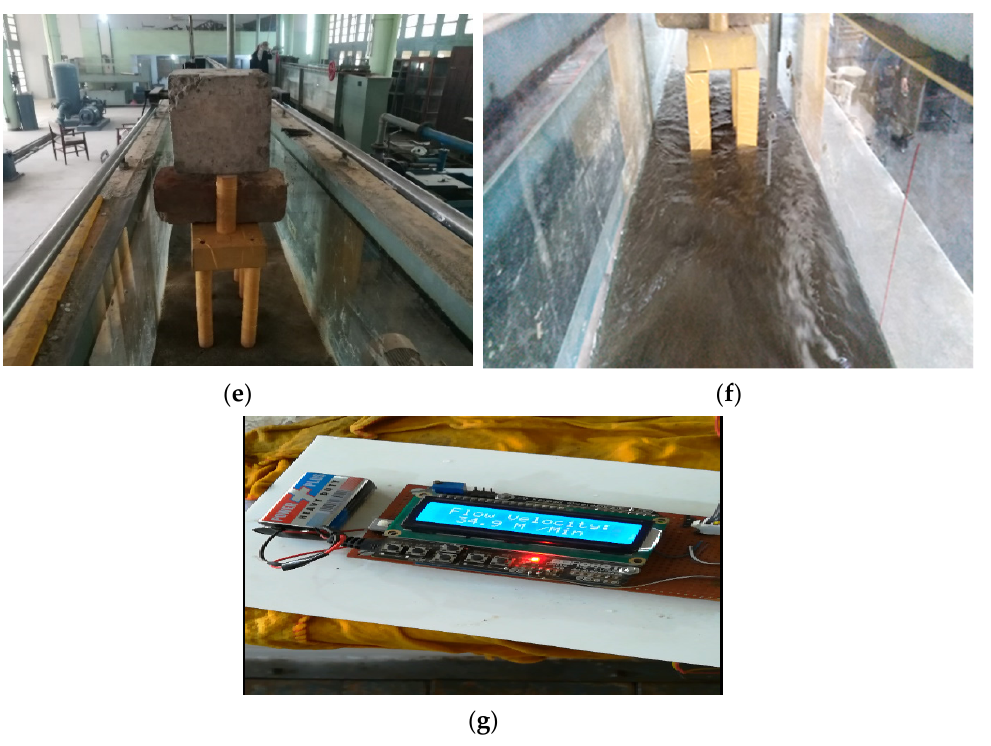
Figure 2. ( a ) Existing Pakhtoon Gari Bridge. ( b ) Model prepared for laboratory test. ( c ) Model fitted in flume test section. ( d ) Fixing of piles with pile cap. ( e ) Front view of the test section. ( f ) Square piles subjected to water current. ( g ) Electronic velocity meter.